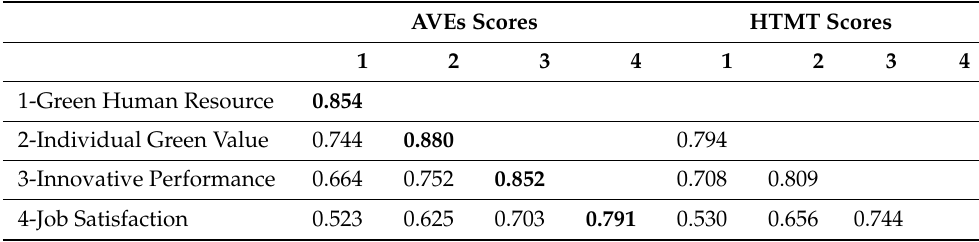
Table 4. Discriminant validity calculations.